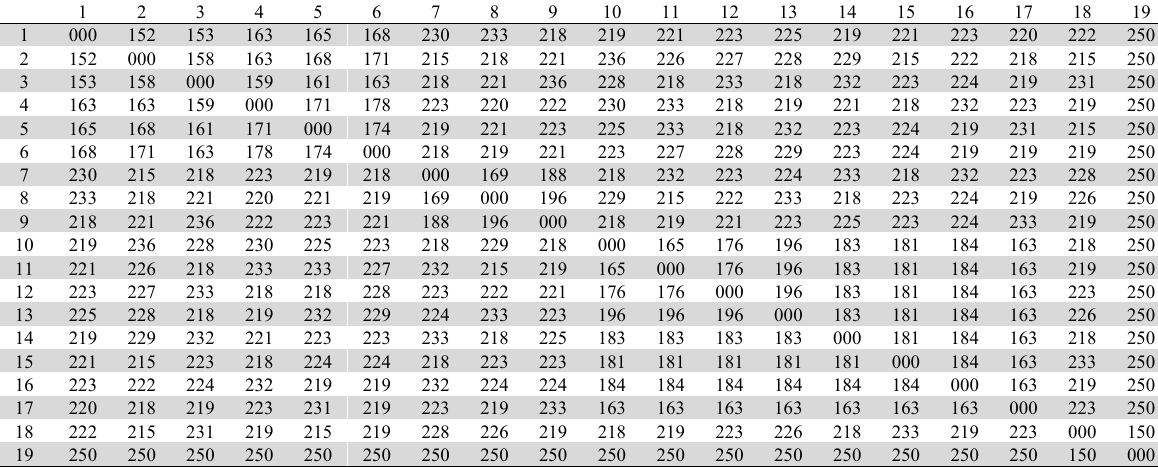
Electricity purchase price between peers (USD/MWh). P2P and INT models